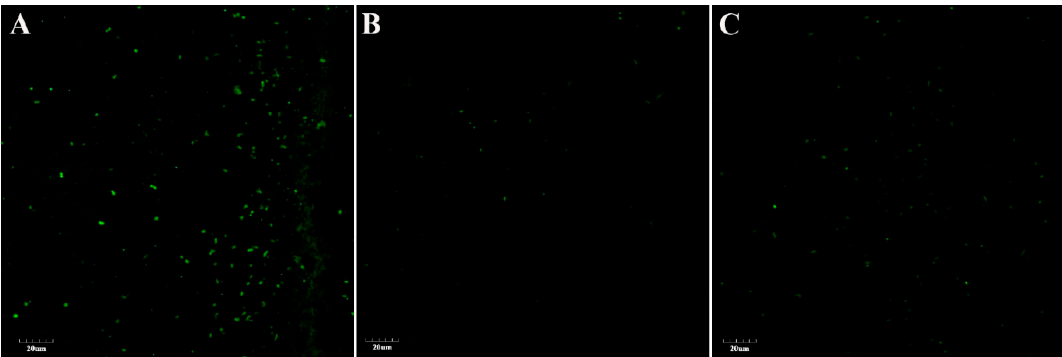
Figure 4. The higher level of green fluorescence indicating the higher level of Reactive Oxygen Species (ROS) in FZB42 strain grown for 96 h at 4 °C ( A ). The lower fluorescence depicts lesser ROS production in the cells of strain CJCL2 ( B ). The level of ROS as shown by fluorescent cells in strain RJGP41 ( C ).